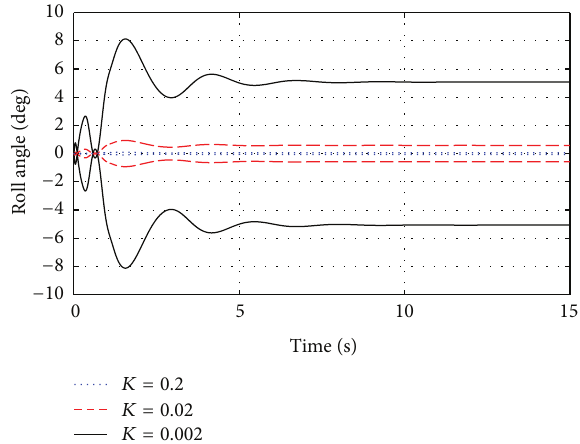
Figure 9: Outer roll angles for a fixed damping ratio and varying spring